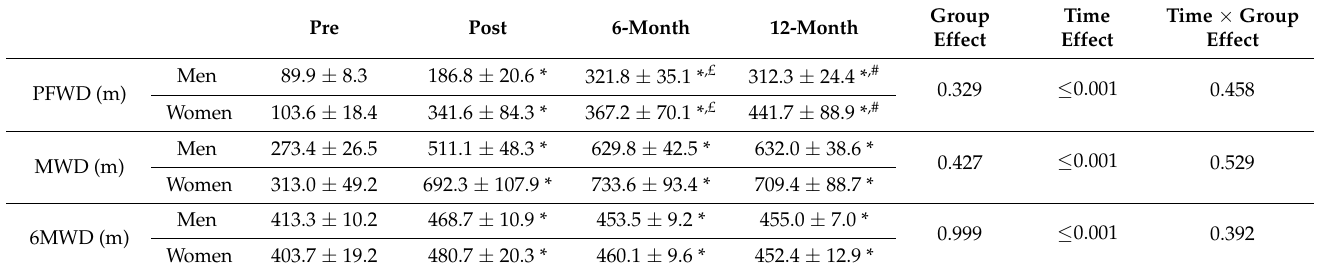
Table 4. Walking performance in women and men before, after, 6 months, and 12 months post supervised exercise training